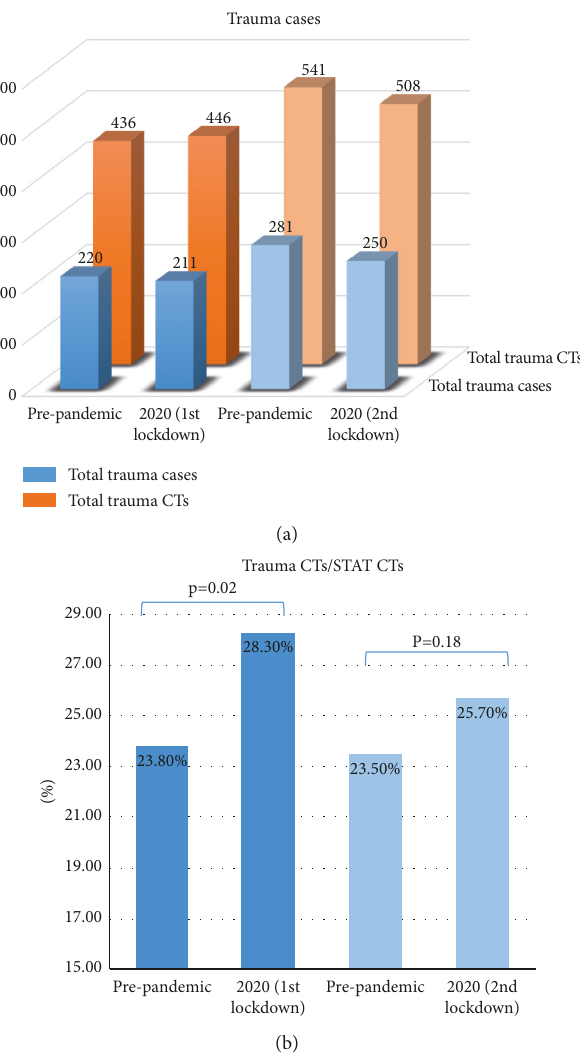
Figure 2: (a) The total number of trauma cases and trauma-related CT scans in our level 1 trauma center in two COVID-19 lockdown periods in 2020 versus the prepandemic period in 2019. (b) The comparison of the relative ratio of trauma CTscans to ED CTscans among two lockdown periods as compared to control prepandemic